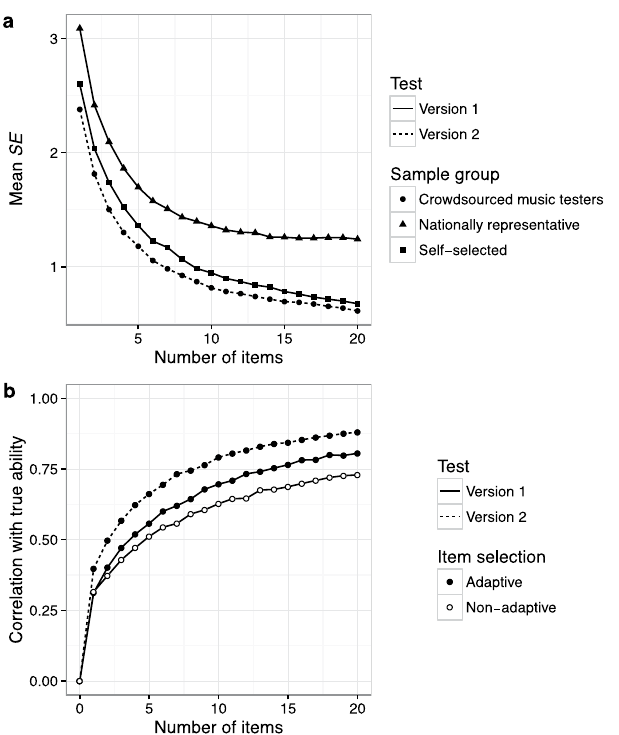
Figure 6. Reliability as a function of test length, sample group, and test version, as assessed by ( a ) mean SE of ability estimates and ( b ) Pearson correlation between estimated abilities and true abilities (simulation